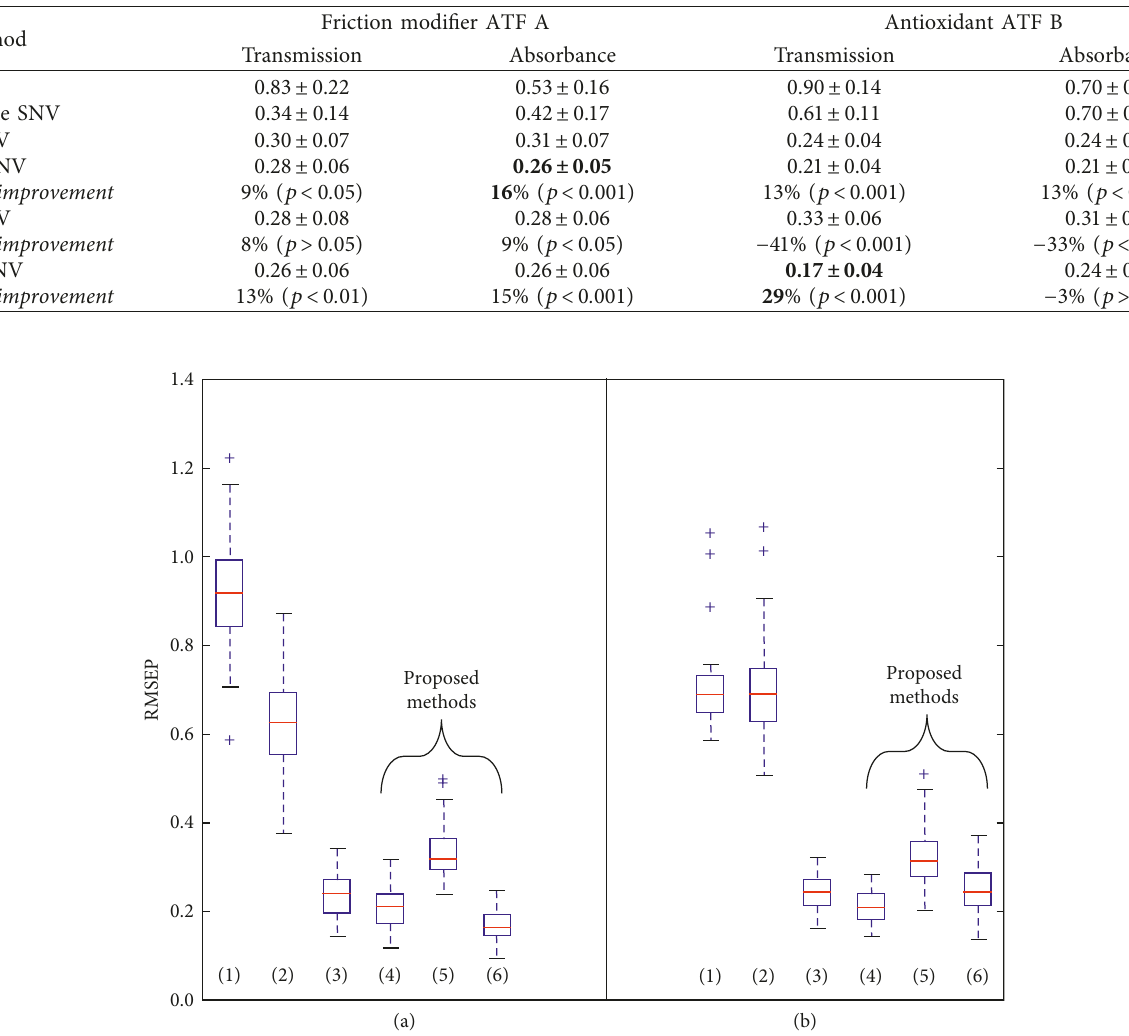
Figure 10: Box-and-whisker plot representation of the root-mean-squared error of prediction of the cross validation strategy for the phenolic antioxidant compound of ATF B. In (a), the RMSEP values for the transmission spectra are shown, and in (b), the RMSEP values for the absorbance spectra are shown. Boxplot (1) is without standardization, (2) is with a single SNV transformation on the full spectrum, (3) is with optimized LSNV, (4) is with optimized Dynamic DLSNV, (5) is with optimized PSNV, and (6) is with optimized PPSNV.